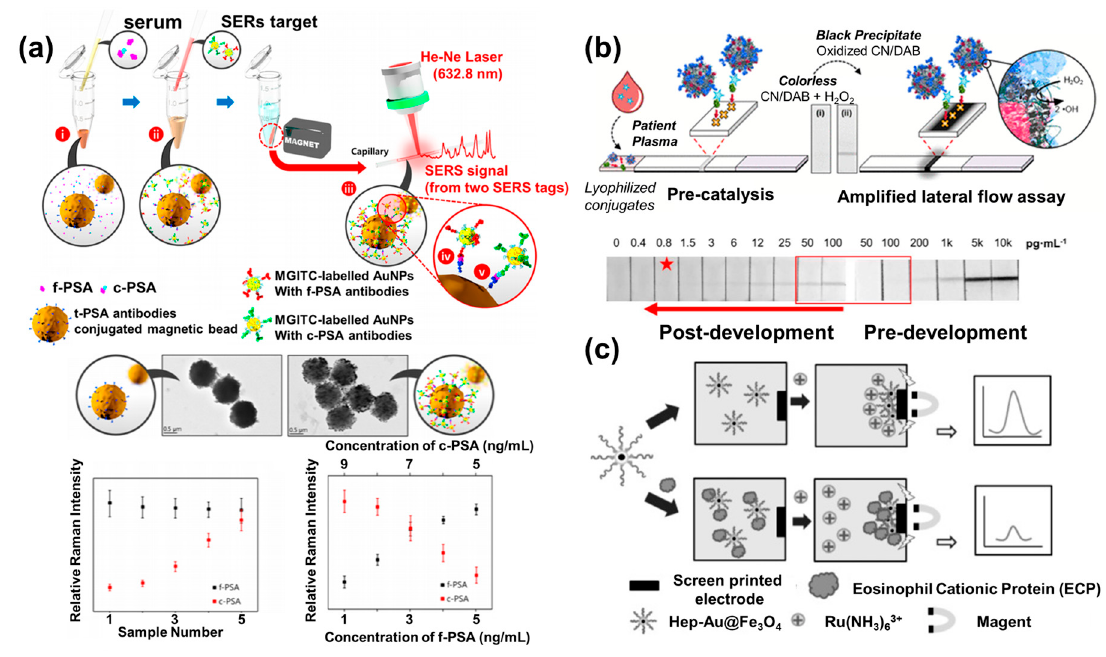
Figure 2. Biosensors developed based on nanoparticles (NPs). ( a ) A schematic of a surface-enhanced Raman spectroscopy (SERS)-based biosensor based on Au and magnetic NPs to detect and distinguish two different prostate-specific antigens (PSAs) for the accurate diagnosis of prostate cancer, with TEM analysis of magnetic NPs with antibodies and formation of a sandwich structure, and SERS results for PSA solutions prepared with different ratio of complexed (c)-PSA and free (f)-PSA (reproduced with permission from Reference [47], published by the American Chemical Society, 2017). ( b ) A highly sensitive optical lateral flow assay (LFA) biosensor based on catalytic Pt NPs for the detection of the human immunodeficiency virus (HIV) p24 biomarker, and detection of colorimetric band formation on the LFA chip before and after addition of hydrogen peroxide to the Pt NPs on the chromogenic substrate (reproduced with permission from Reference [48], published by American Chemical Society (ACS), 2017, (https://doi.org/10.1021/acsnano.7b06229, further permission related to this material should be directed to the ACS)). ( c ) A schematic of an electrochemical eosinophil cationic protein (ECP) biosensor based on Au-coated magnetic NPs (reproduced with permission from Reference [50], published by Elsevier, 2017).